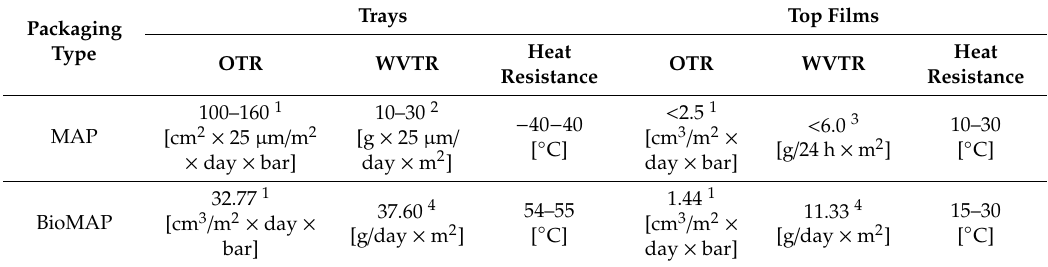
Table 1. OTRs, WVTRs and heat resistances for trays and top films of MAP and BioMAP. Packaging Type